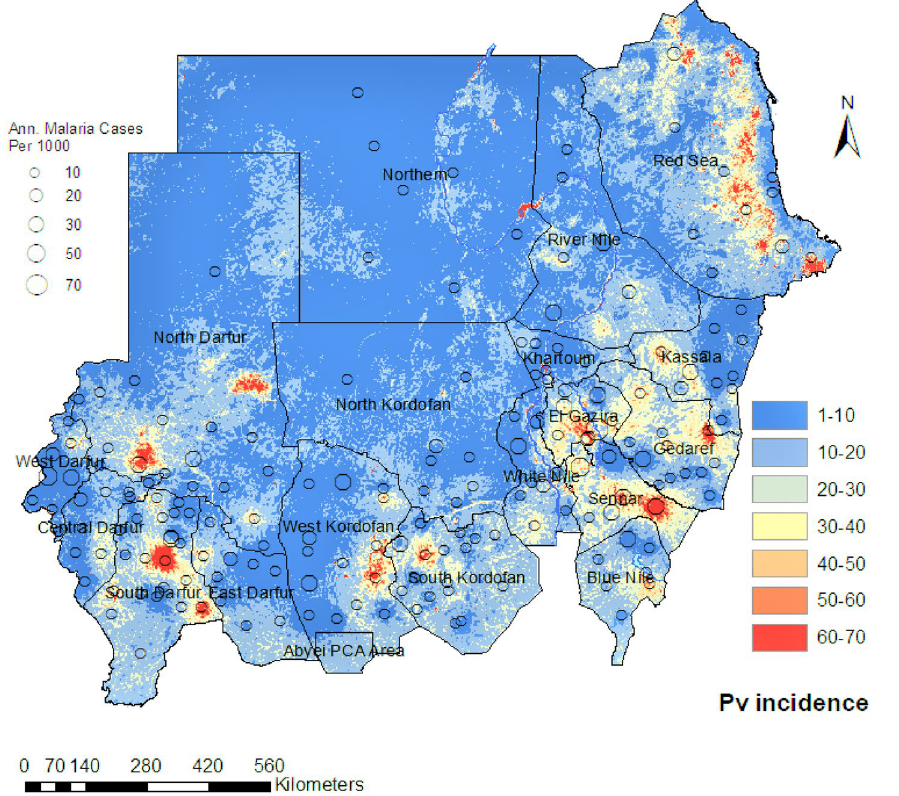
Figure 6. A fine-scale map ( 1 × 1 km) of the incidence cases of the P. vivax malaria per 1000 in Sudan inferred based on our spatiotemporal Bayesian model fit to the routine surveillance data between 2017 and 2019. Hollow circles represent reported cases per year within each